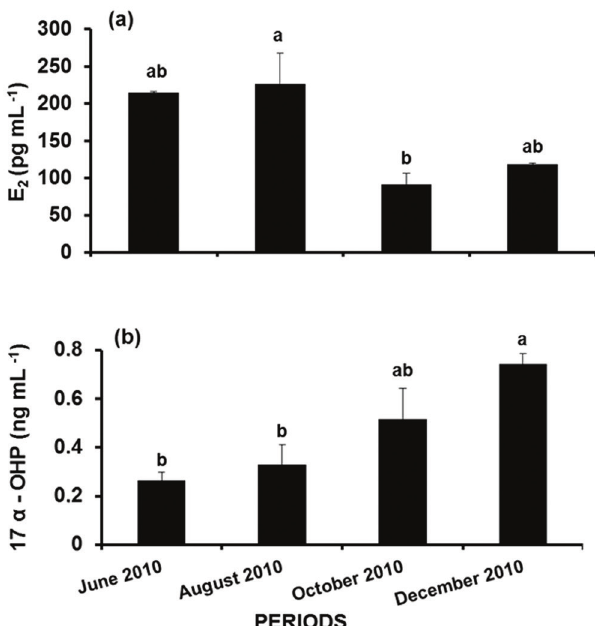
Fig. 4. (a) Mean ( ± S.E.M) bimonthly plasma concentrations of E in Metynnis maculatus females (n = 20). Different letters indicate significant differences among months (ANOVA, Tukey test, P < 0.05). (b) Mean ( ± S.E.M) bimonthly plasma 17 α – OHP concen- trations (n = 20). Different letters indicate significant differences among months. (ANOVA, Tukey test, P <